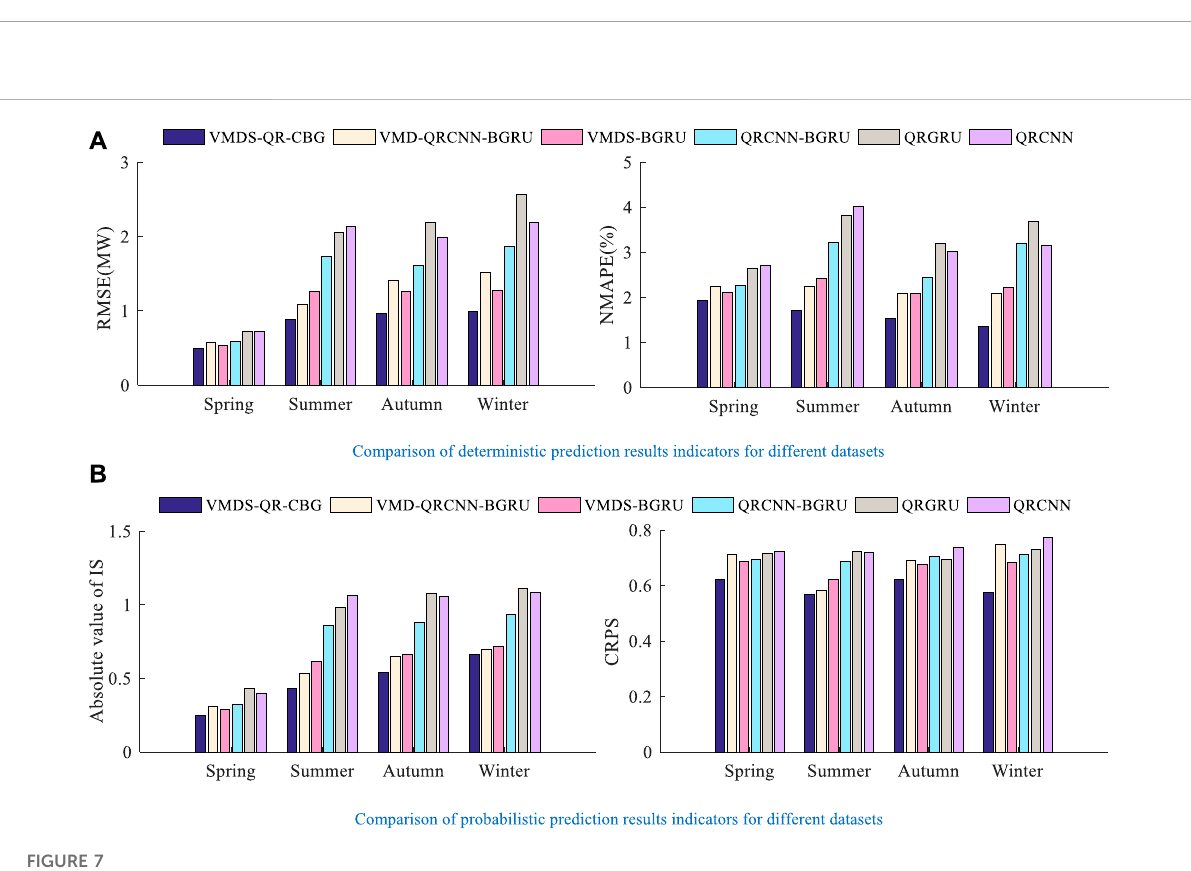
FIGURE 6 Point prediction results of Datast1 of different models.